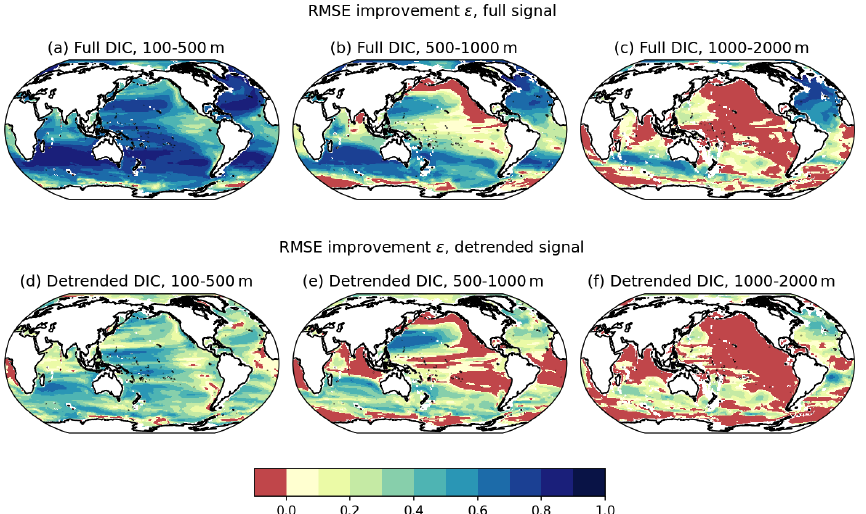
Figure 8. Average RMSE reduction ε , relative to a climatology, for sensitivity tests with out-of-sample models: panels (a–c) use average ε for the full DIC (cid:48) signal and panels (d–f) use average ε for the detrended signal. The average RMSE reduction is calculated for individual depth levels: 100–500m (a, d) , 500–1000m (b, e) , and 1000–2000m (c, f)